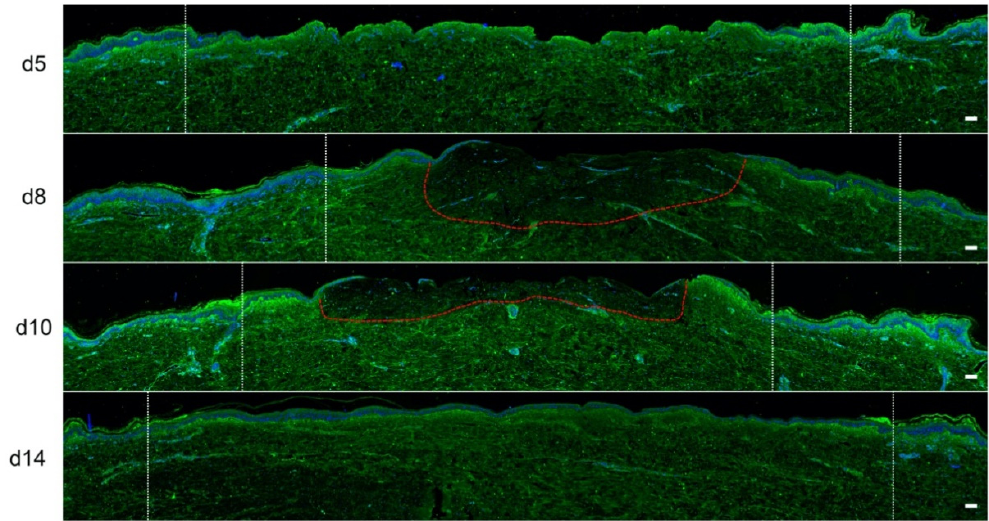
Figure 8. Kinetics of procollagen III synthesis in poloxamer hydrogel-treated ex vivo cultured human skin explants submitted to 10 s long experimental burn injury. Immunostaining of procollagen III was performed on gel-treated human skin explants harvested at different time points post burn (days 5, 8, 10, and 14). After wound debridement, on day 1, daily treatment with poloxamer p407/p188 hydrogel was applied. No significant change was observed on day 5 in the burn area compared to healthy skin. On day 8, a decreased intensity in procollagen III staining (area delimited by a red dotted line) was observed in the dermal area adjacent to the burnt epidermis. On day 10, this decrease in procollagen III staining intensity was less pronounced but still present until it returned to baseline levels on day 14. Experiments were performed on skin explants derived from three donors. White dashed lines delineate the burnt area. Scale bar: 100 µm.